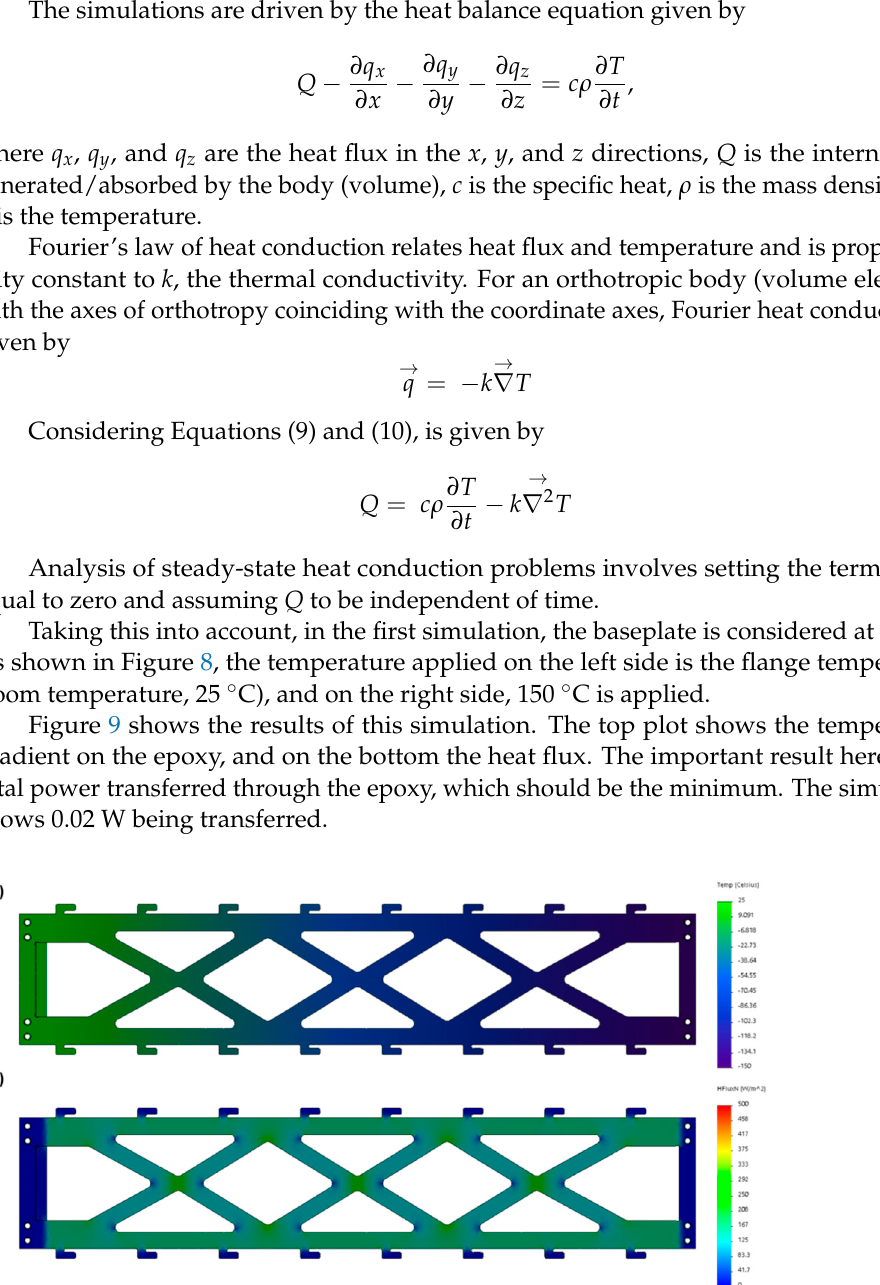
Figure 10. Thermal analysis of the outer epoxy support when the large clutch is at 150 °C. ( a ) A temperature map and ( b ) the heat flux. The power transferred in this simulation was about 0.015 W.